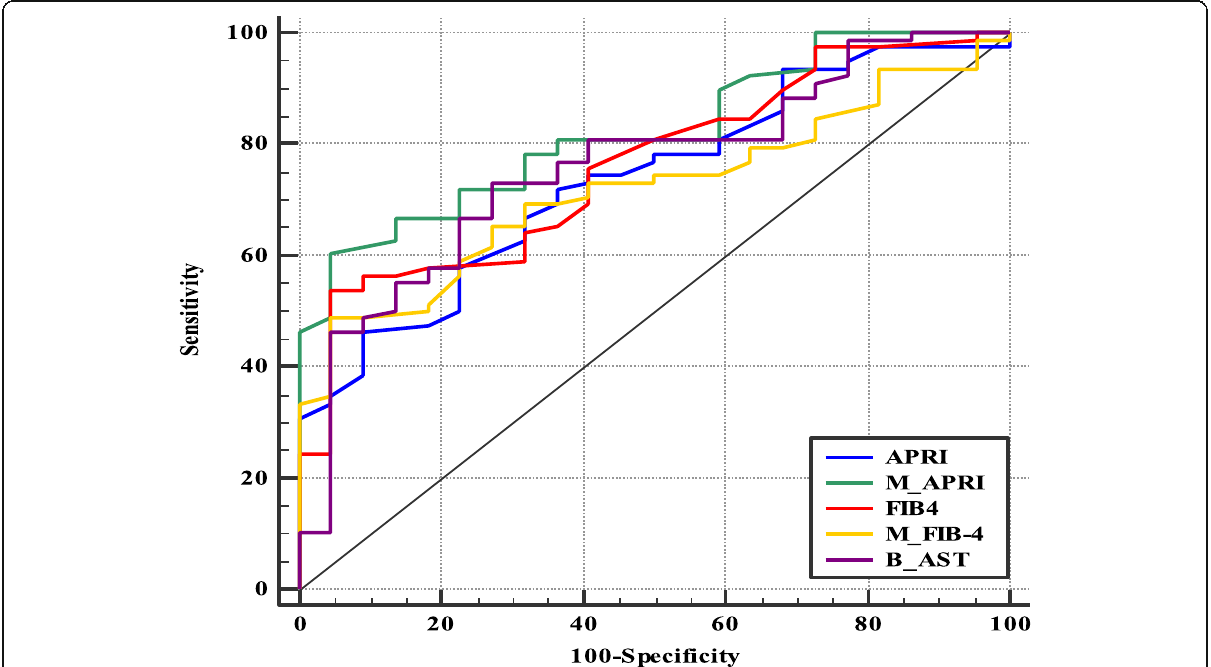
Fig. 1 Diagnostic performance (ROC curves) of the studied non-invasive biomarkers in the detection of early fibrosis (F1 –